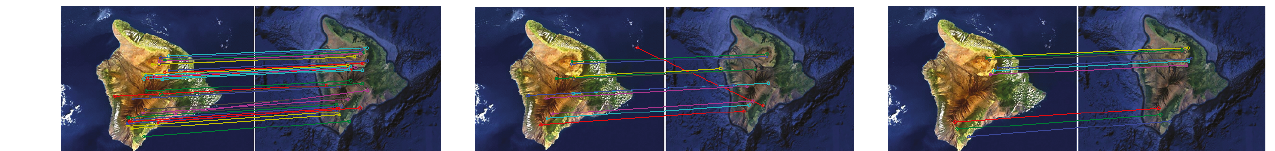
Figure 18: Hawaiian island registration result with SURF, PCA-SURF, and CSA-SURF.